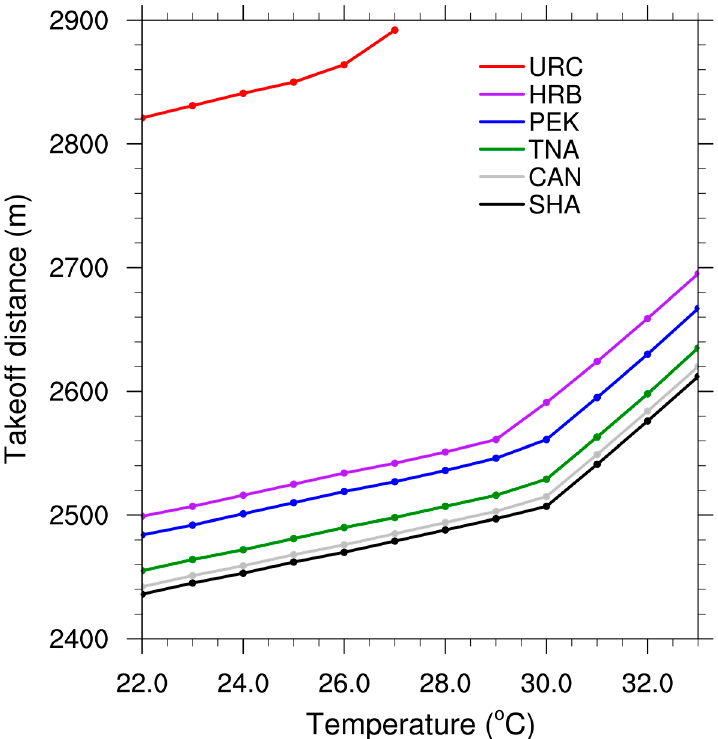
Figure 7. The relationship between takeoff distance (m) and temperature (°C) when the MTOW is 174,000 lb at the selected airports except KMG and LXA.